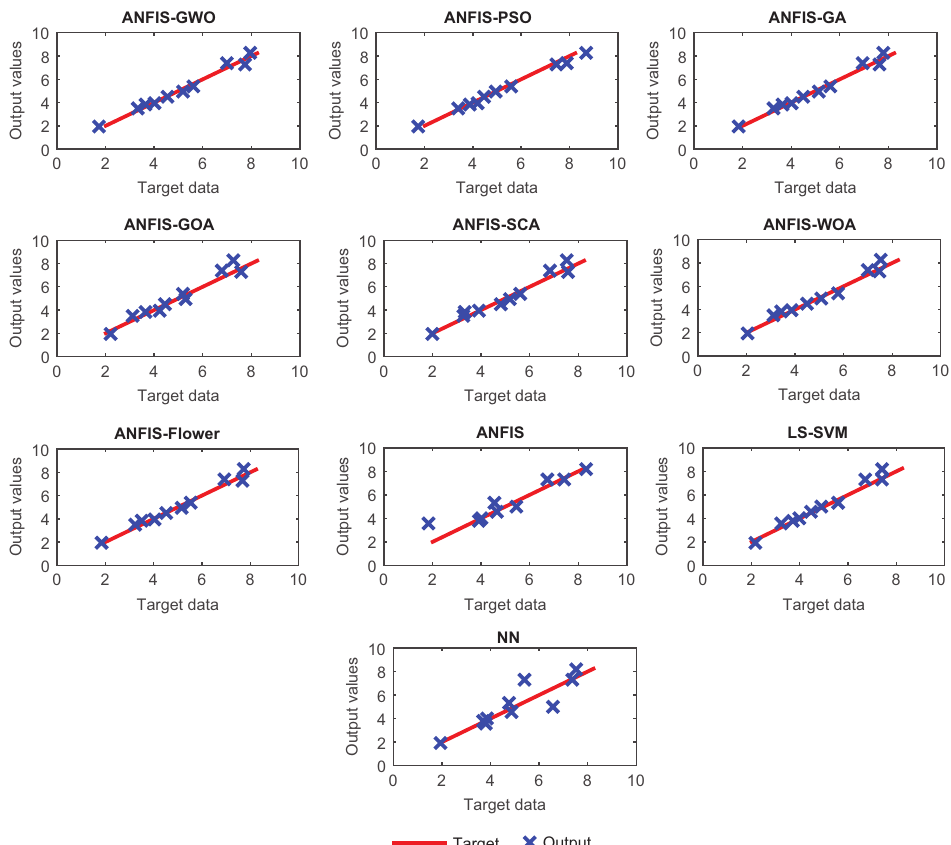
Figure 10: Predicted Data of All Algorithms against the Target (Real) Data.